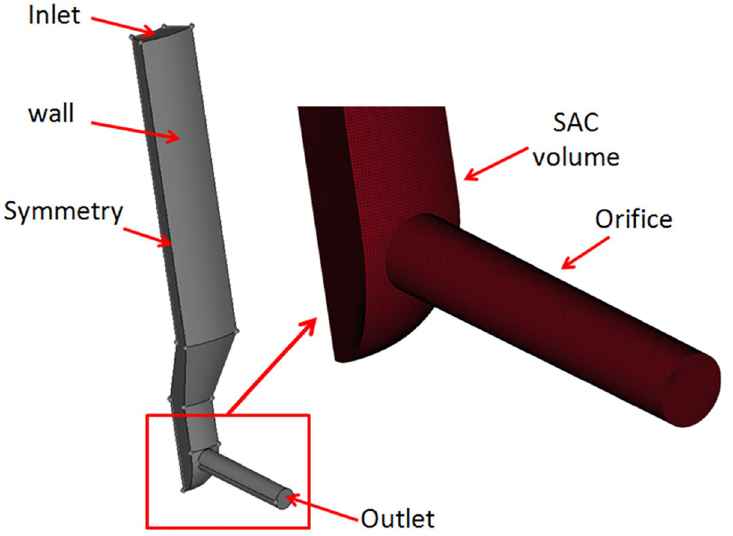
Fig 2. Computational nozzle model and orifice mesh